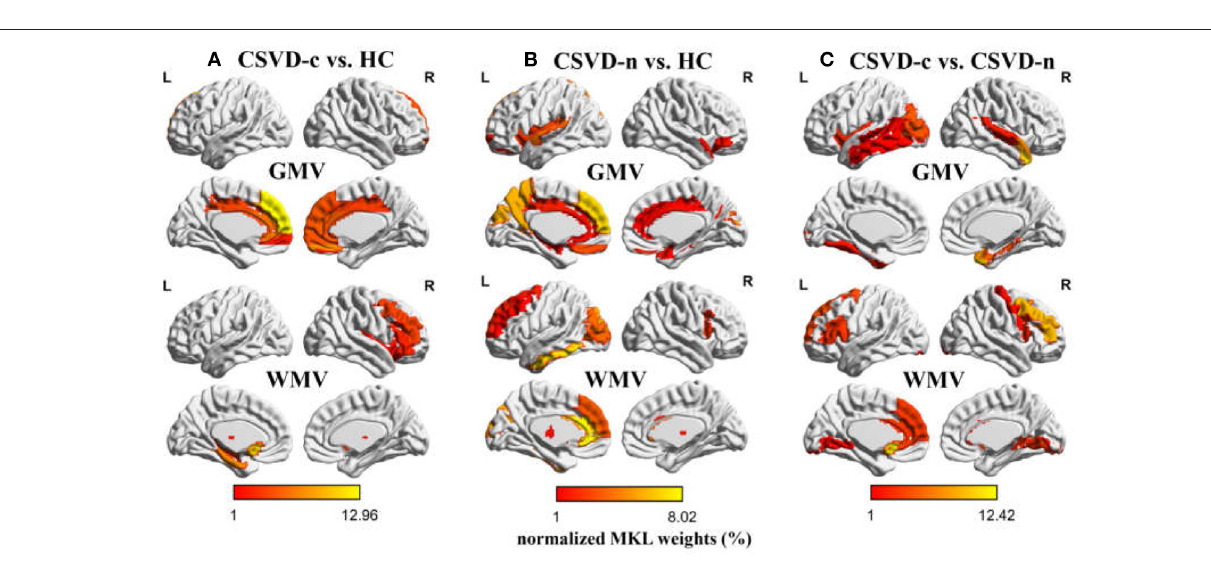
FIGURE 5 | Weight (per region) maps modeled by multi-kernel learning (MKL) combining GMV and WMV features. As a simple kernel model was implemented by MKL-SVM, the weights per voxel will be averaged (in absolute value) within each ROI as defined by AAL atlas. The regional MKL weights representing regional contribution to (A) CSVD-c vs. HC, (B) CSVD-n vs. HC, and (C) CSVD-c vs. CSVD-n classification problems were rendered on the ICBM152 template. Weights with lower (1% or less) contribution are not shown. HC, healthy